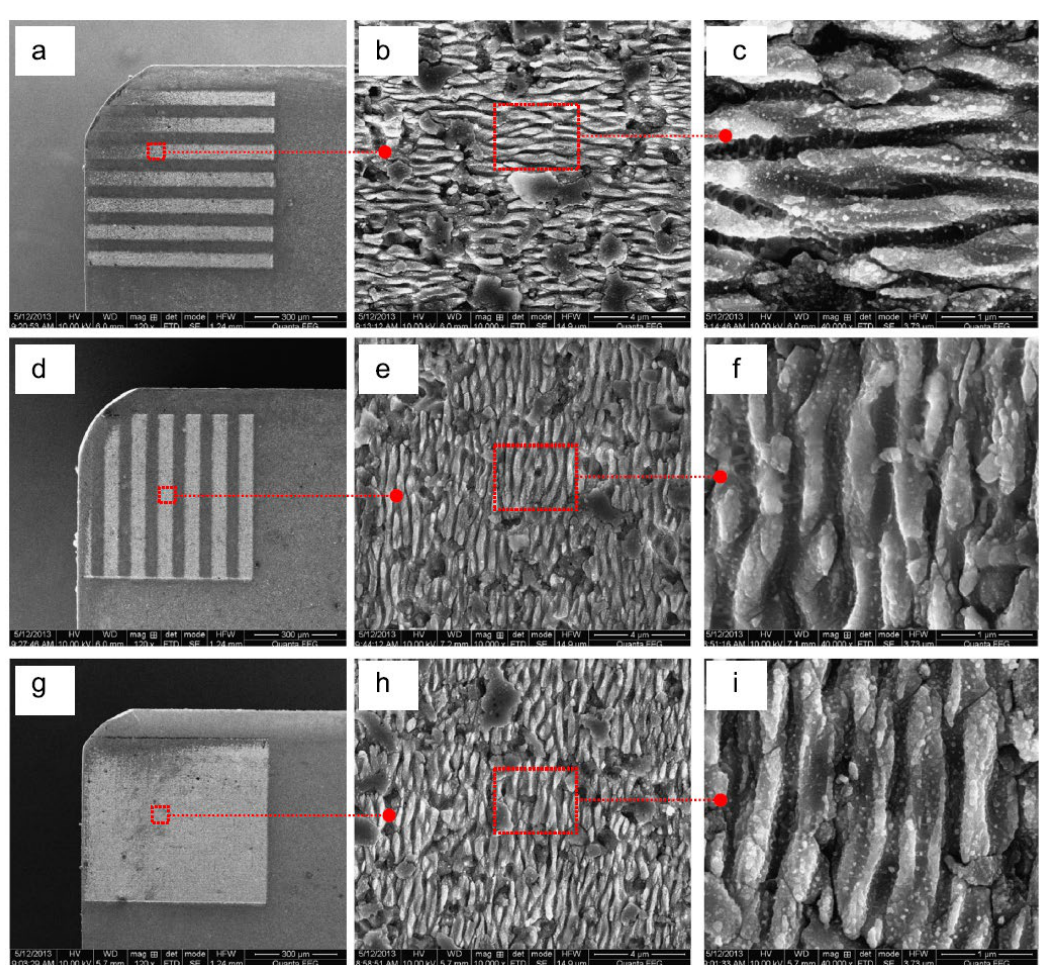
Figure 7. SEM images of the three types of nanotextures on the tool rake face: ( a )–( c ) AN-PE; ( d )–( f ) AN-PA; ( g )–( i ) AN-A [40].